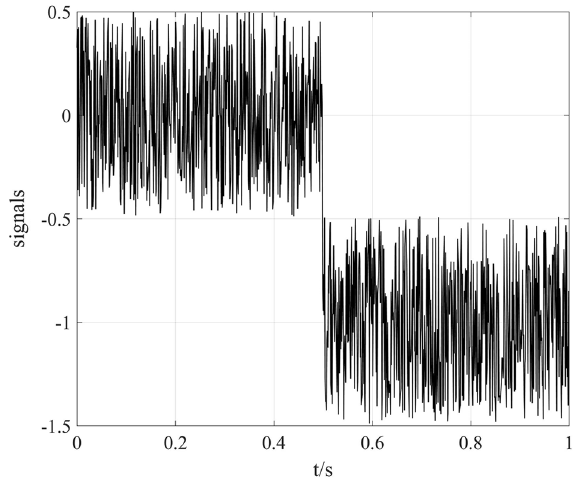
Figure 2. Simulated signals y ’ ( t ) with a step trend